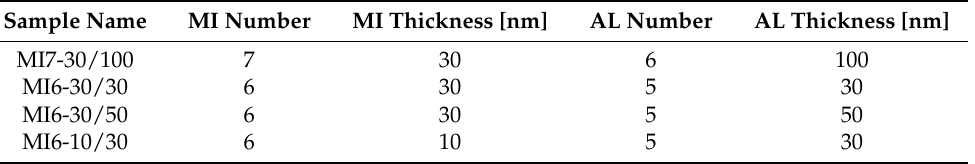
Figure 7. Temperature evolution of the checkerboard sample: ( a ) TEM images acquired between 323 K to 403K and their corresponding FFT diffraction pattern ( b ). All FFTs have been contrast adjusted. ( c ) TEM image of the specimen recorded at 103 K (enhanced in contrast to make the Moir é pattern more visible) and corresponding SAED pattern. Table 1. Overview about the details of the investigated sample systems. The sample names contain the number of the martensitic intercalation (MI) and the nominal thicknesses of the layers in nm for MIs and active layers